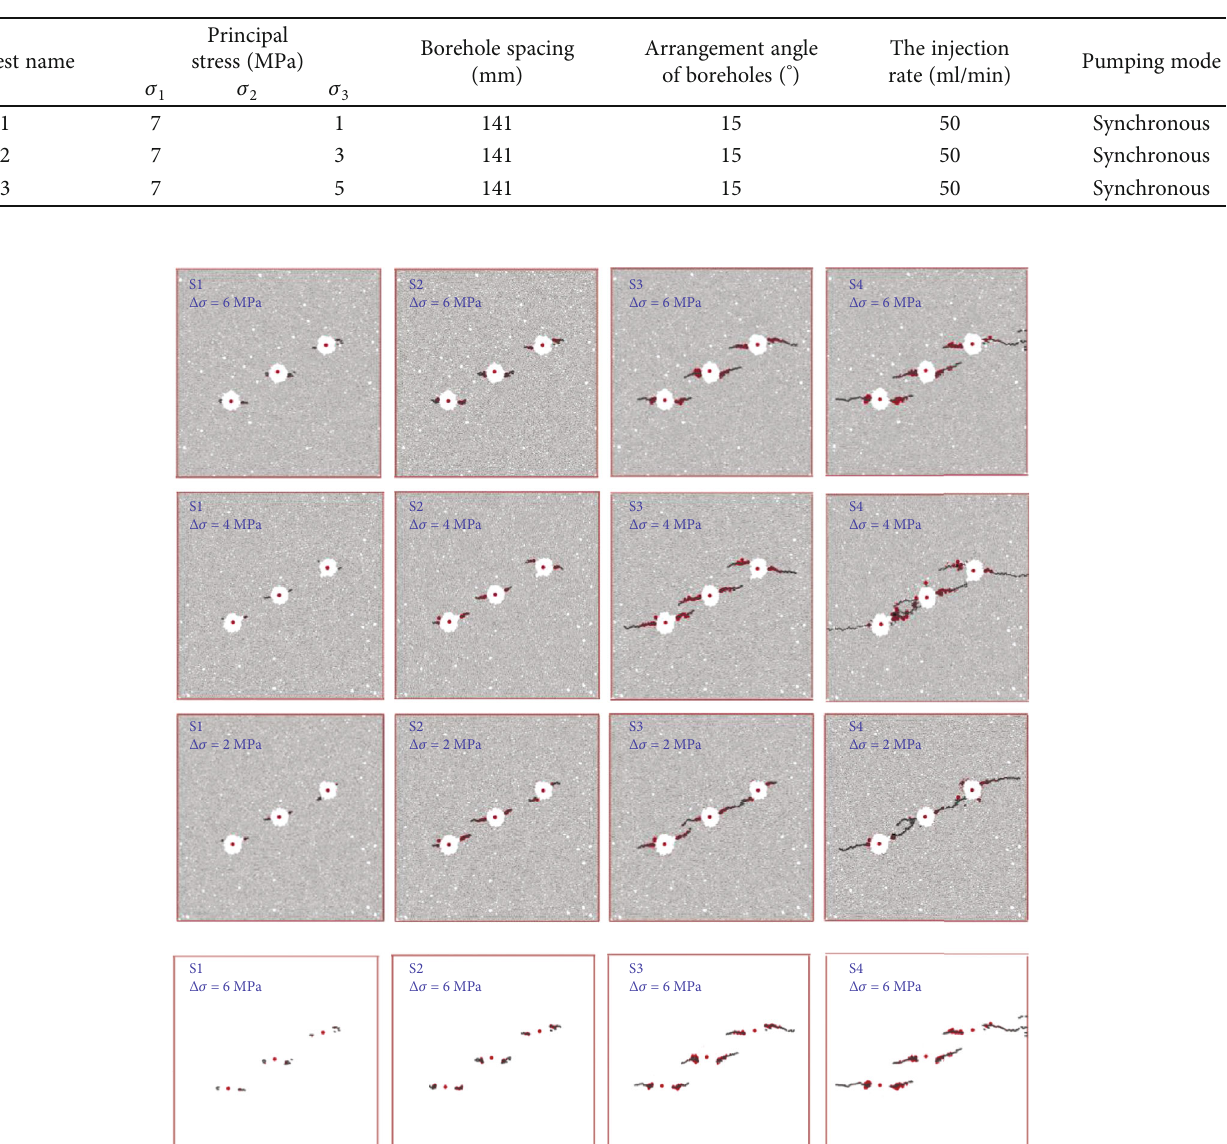
Table 5: Experimental scheme of directional hydraulic fracturing.